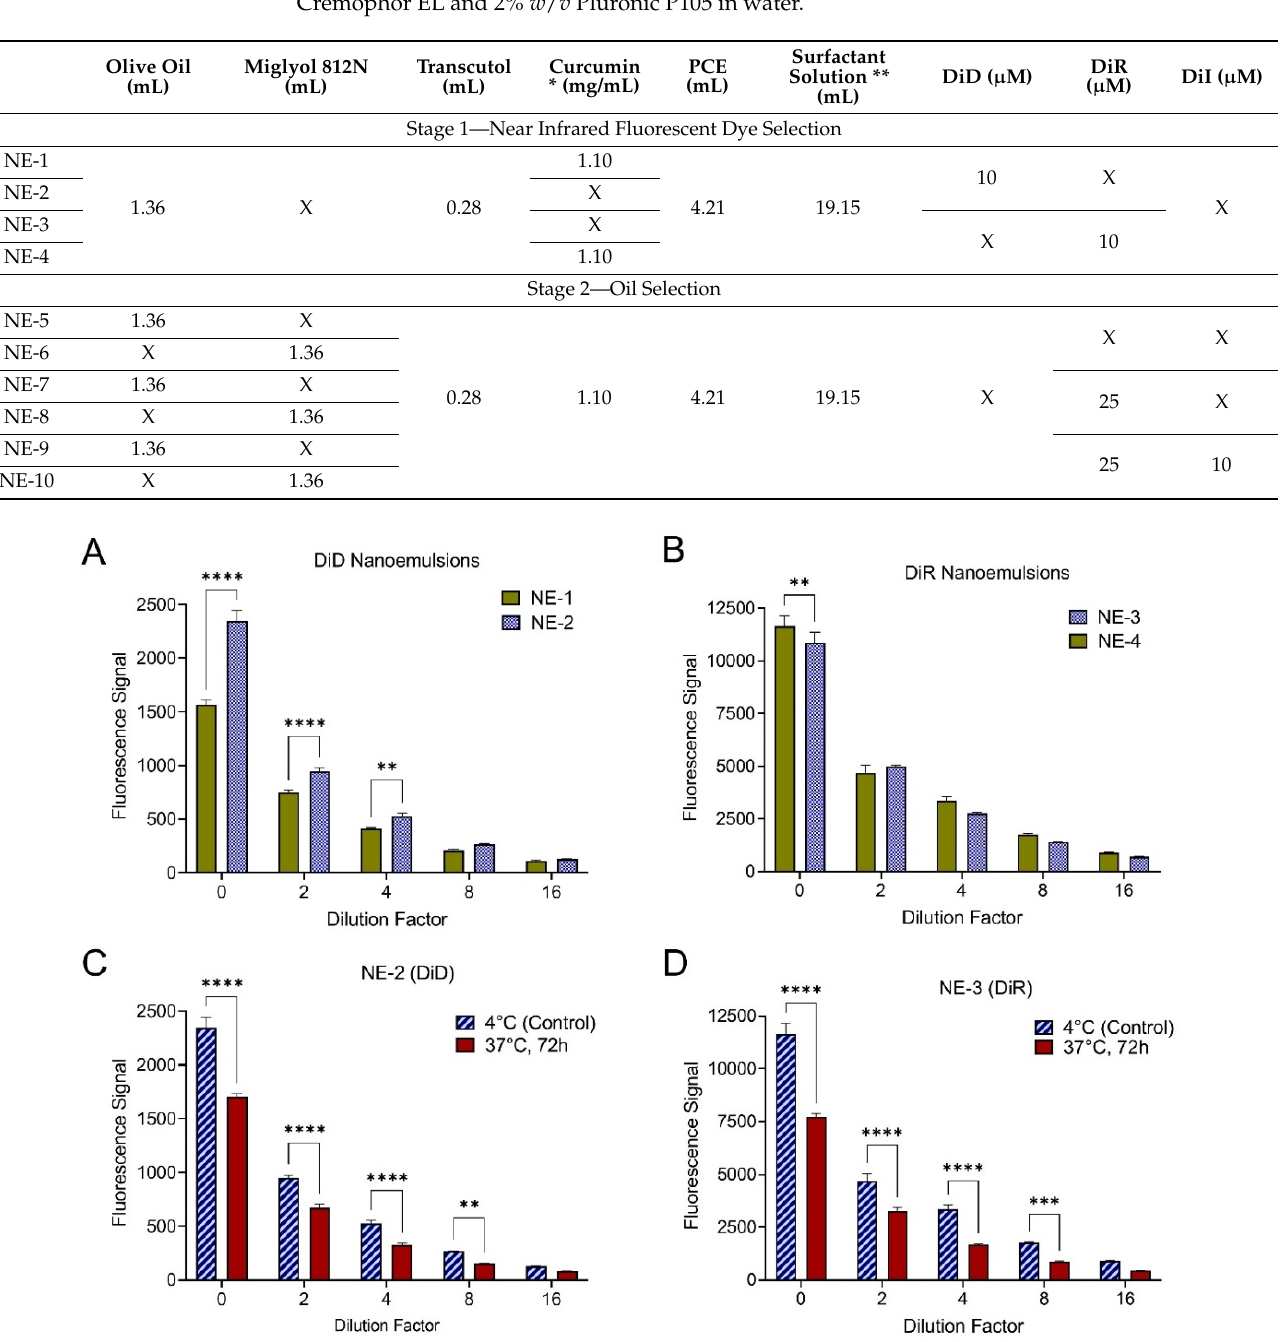
Table 9. Nanoemulsion formulations developed to identify the most suitable near infrared dye (stage 1) and oil (stage 2) for incorporation into a curcumin-loaded perfluorocarbon nanoemulsion. * Theoretical curcumin concentration (assumes 100% loading). ** Surfactant solution is 3% w / v Cremophor EL and 2% w / v Pluronic P105 in water.